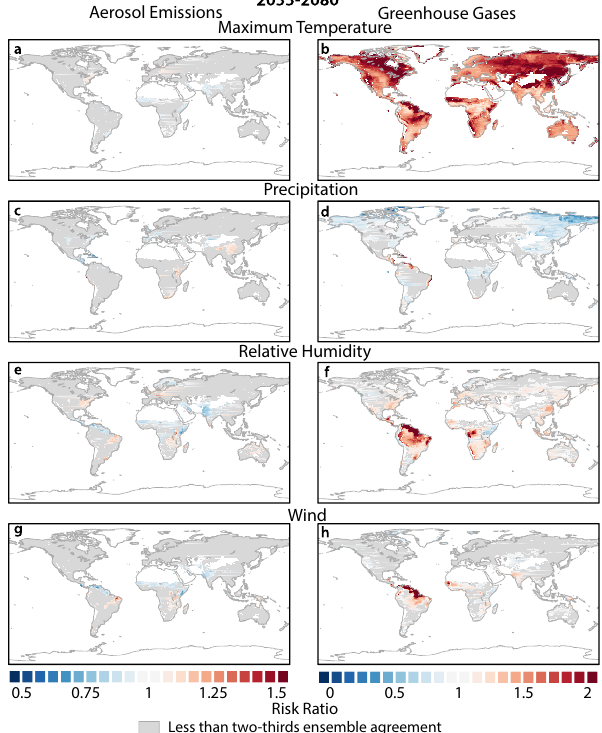
Fig. 3 Isolating the effects of meteorological variables on extreme fi re- weather risk. The risk ratio (RR) is the probability of exceeding the 95th percentile of the baseline daily fi re-weather index (FWI) distribution in the all-forcing (ALL) ensemble divided by the probability of exceeding that same threshold in the all-forcing ensemble after removing the aerosol ( a , c , e , g ) or greenhouse gas ( b , d , f , h ) effect on temperature ( a , b ), precipitation ( c , d ), relative humidity ( e , f ) and wind ( g , h ) in 2055 – 2080. The baseline FWI distribution for each period is the distribution of the FWI in the ALL ensemble in that period. Grid points masked in gray have less than two-thirds ensemble agreement on whether the RR is greater or less than one. Oceans, glaciers, and bare land are masked in white.